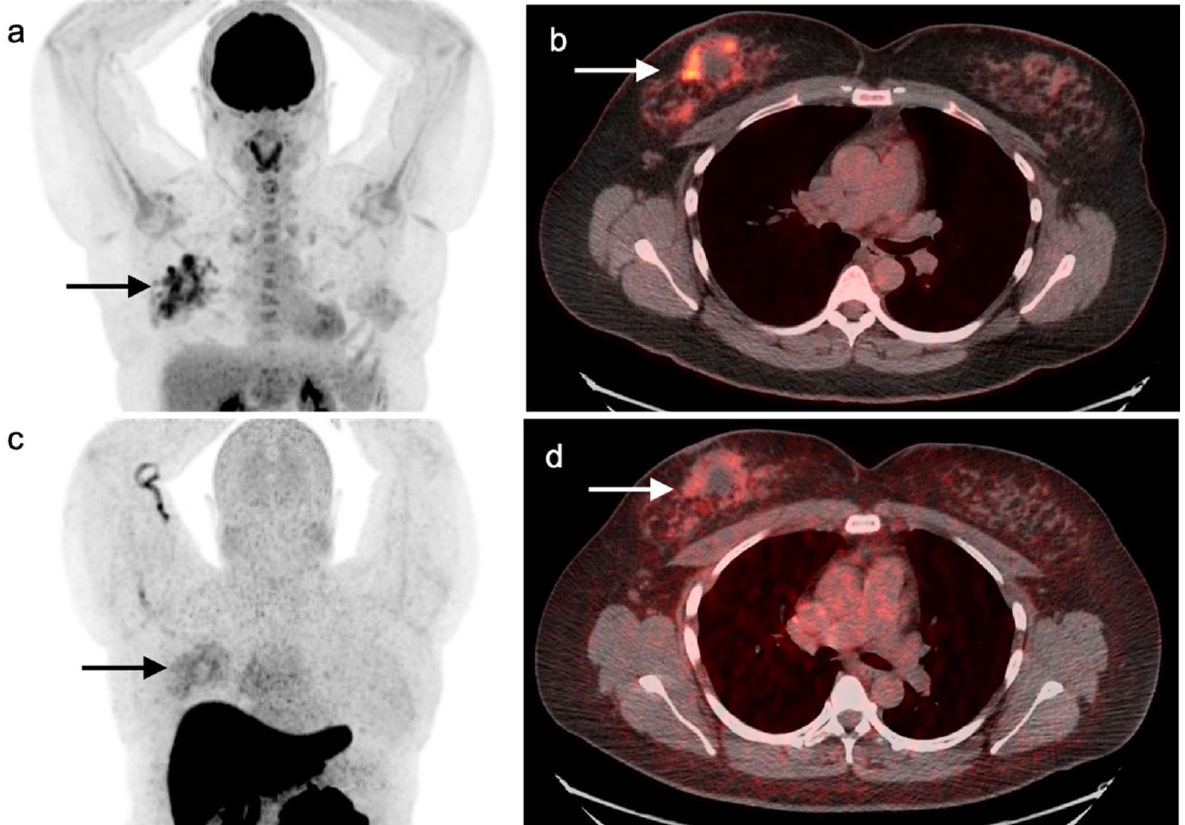
Figure 21. A 42-year-old female with biopsy-proven right breast ER+ invasive lobular carcinoma. Mastectomy demonstrated at least 9 cm of ILC diffusely in the right breast with negative sentinel lymph node biopsy. ( a , b ) FDG PET-CT imaging demonstrates abnormal asymmetric diffuse right breast uptake on MIP ( a , black arrow ) and fused axial PET-CT images ( b , white arrow ); ( c , d ) FES PET-CT imaging demonstrates abnormal diffuse asymmetric right breast uptake on maximal intensity projection ( c , black arrow ) and fused axial PET-CT images ( d , white arrow ).